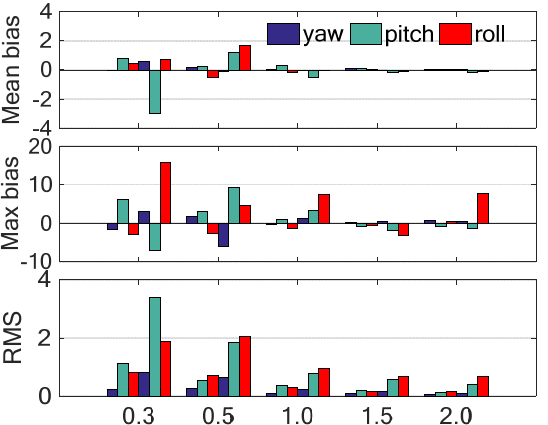
Figure 5. The statistical results of the GPS/BDS attitude solution under five baseline lengths by CLAMBDA-search method, each group of data has a total of six histograms. Three on the left are open-sky results, three on the right are degraded results, where blue is yaw, green is pitch, red is roll. The three panels, respectively, show the average error, maximum error and error RMS of the experiment; the unit of the x-axis is meters.